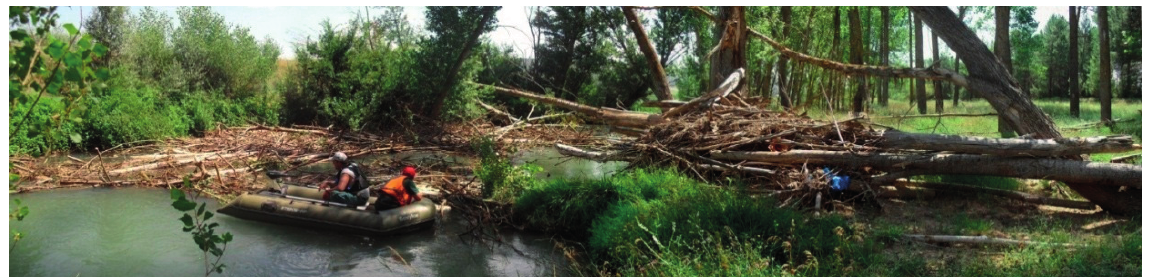
Figure 11. LWD removal action by the water